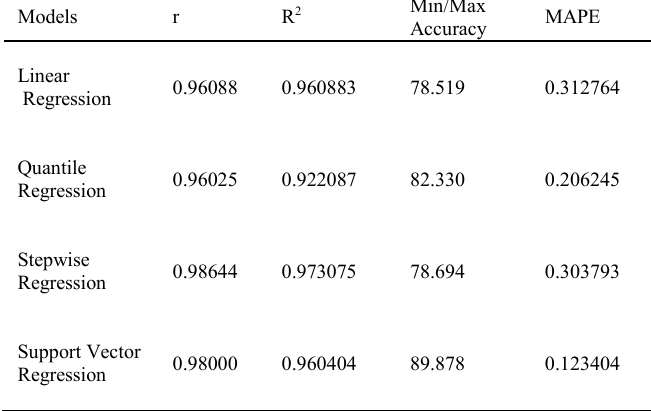
Table 5. Metrics Used for Performance Evaluation of Classification and Ensemble Techniques